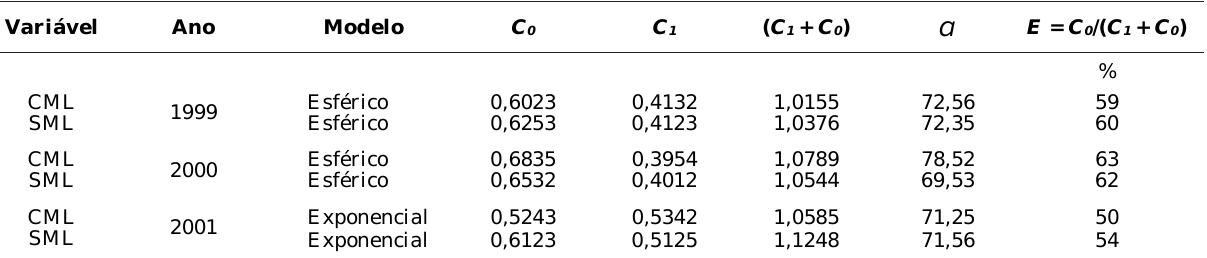
Quadro 3. Parâmetros e modelos dos semivariogramas escalonados para a variável RMSP nas camadas